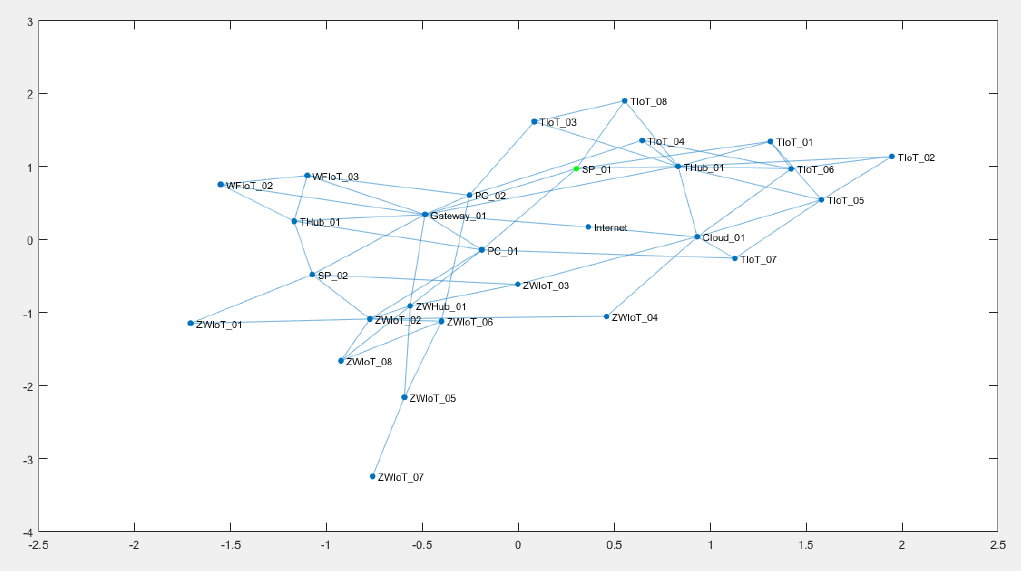
Figure 5. Node SP01 (highlighted) has moved from its original position. This caused the loss of the connection from PC02 and simultaneously the creation of a new connection with node TIoT08